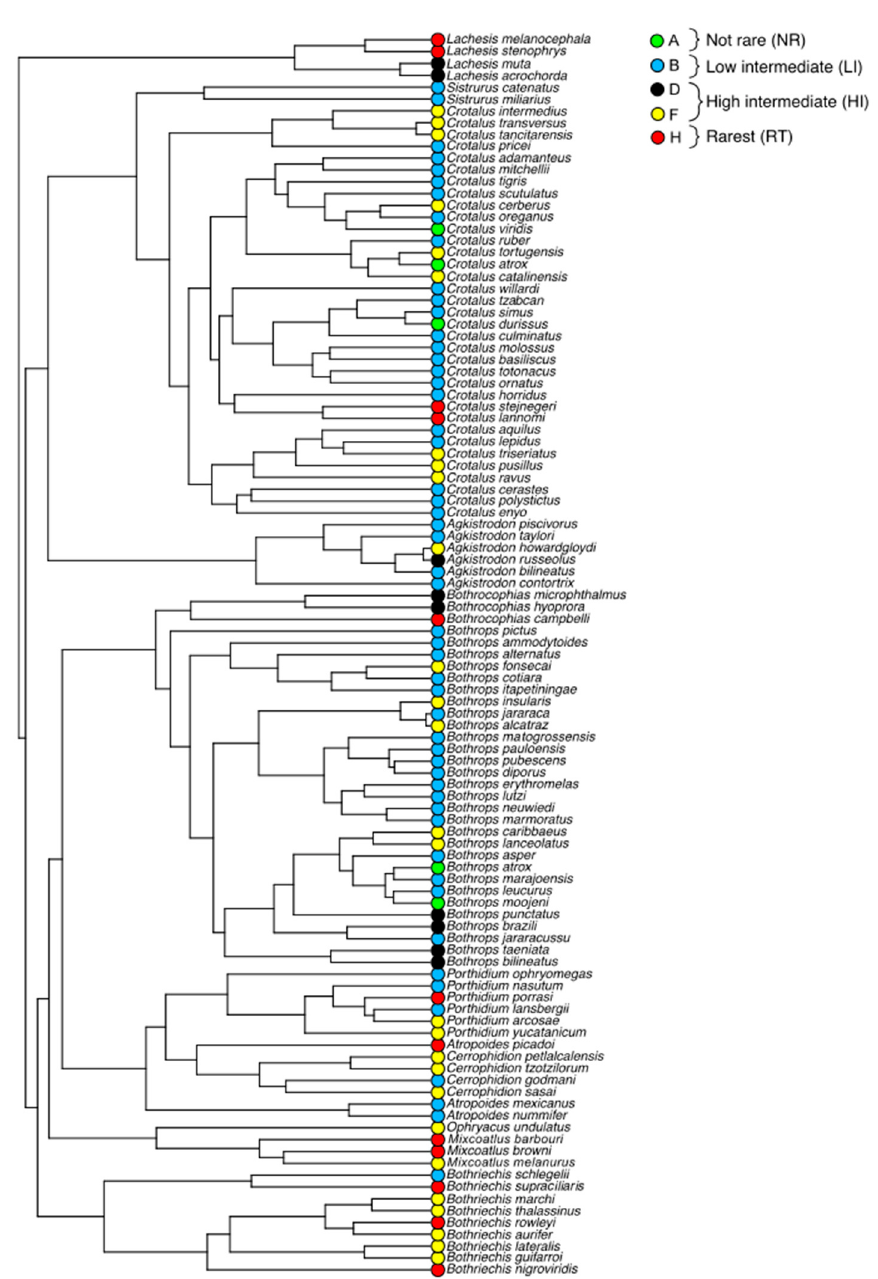
Figure 3. Phylogeny of the New World pitvipers, with colors representing different rarity